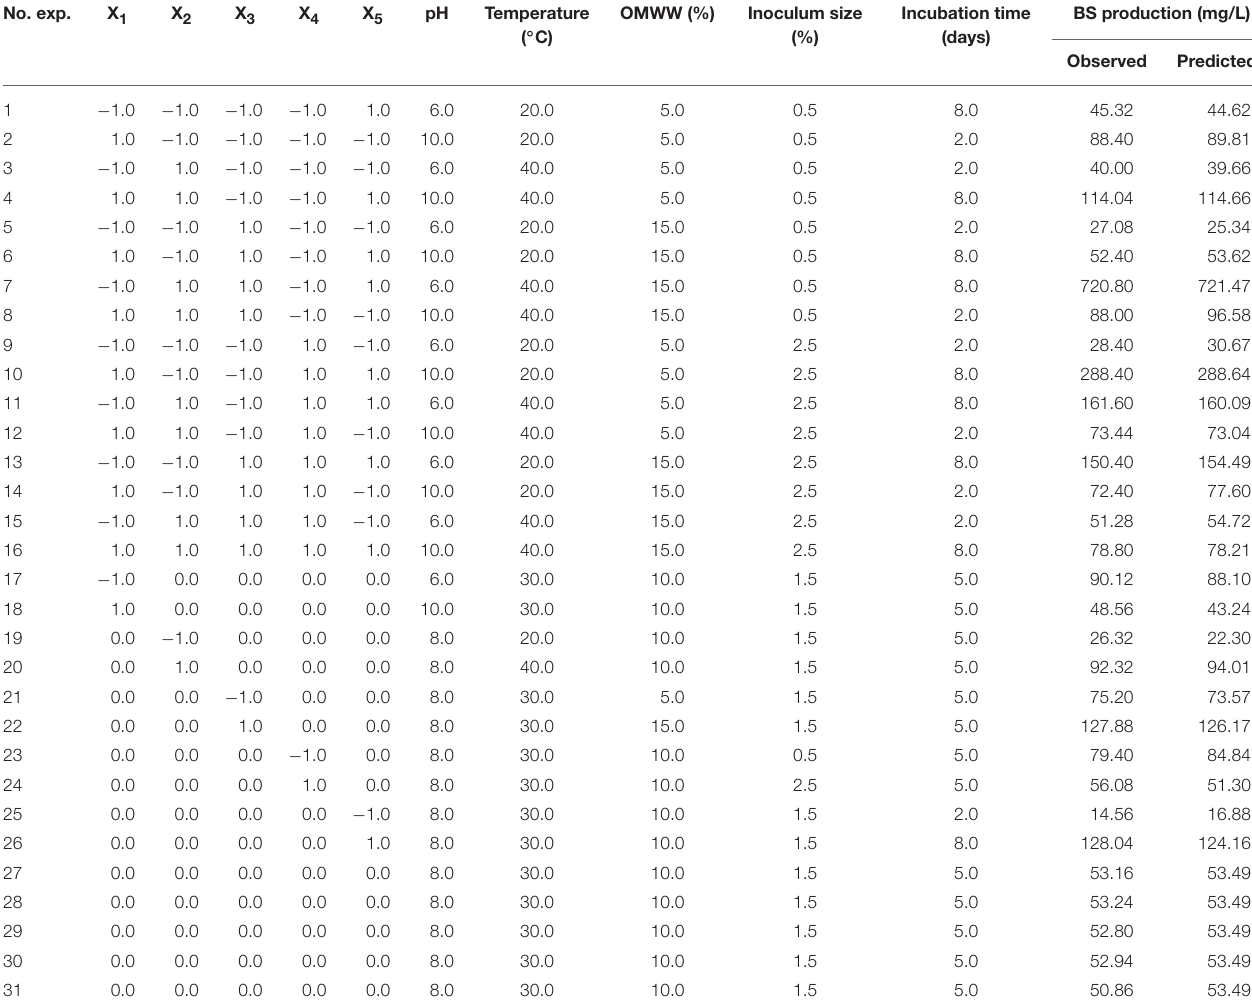
TABLE 1 | Experimental conditions of the CCD design in coded and natural variables and the corresponding observed and predicted responses. No.